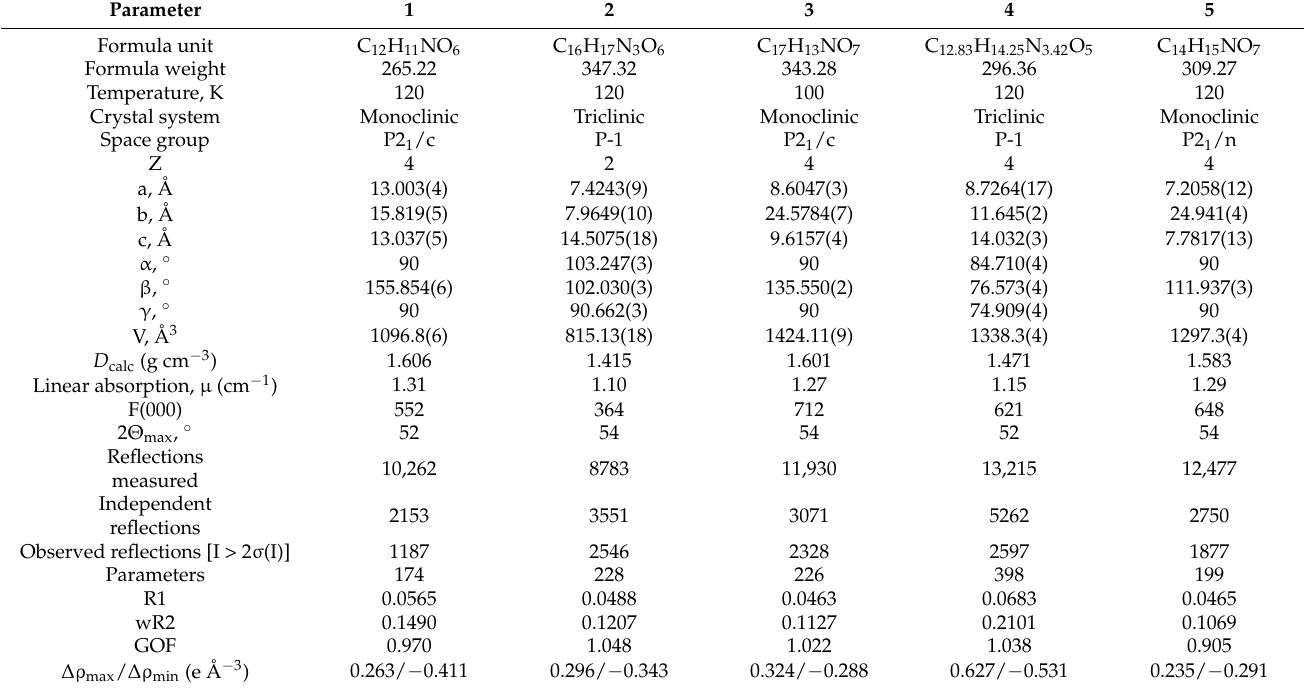
Table 1. Crystal data and structure refinement parameters for 1 – 5